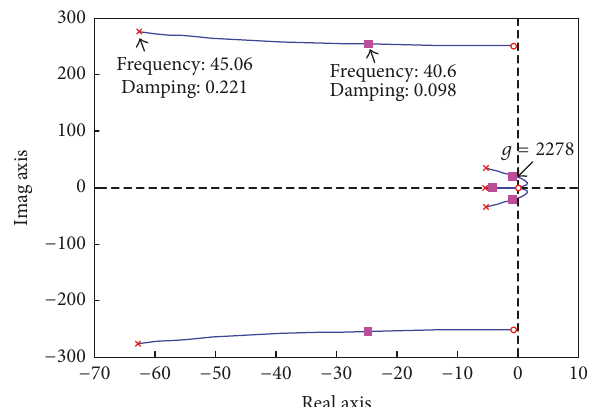
Figure 3: Closed-loop root locus diagram of the system.